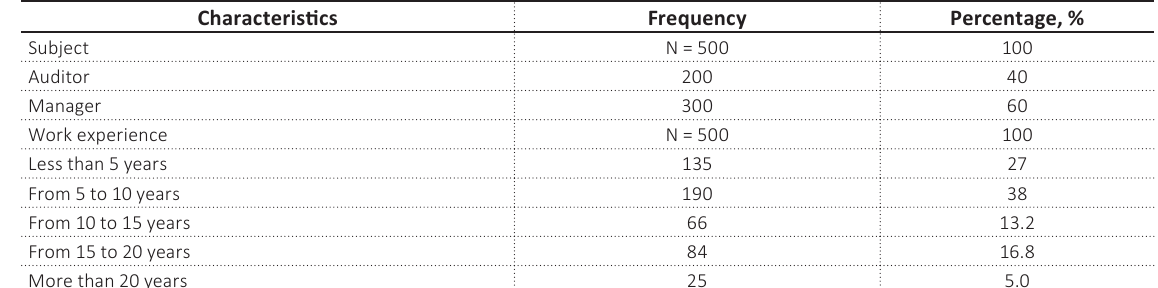
Table 1. Descriptive statistics of the survey sample